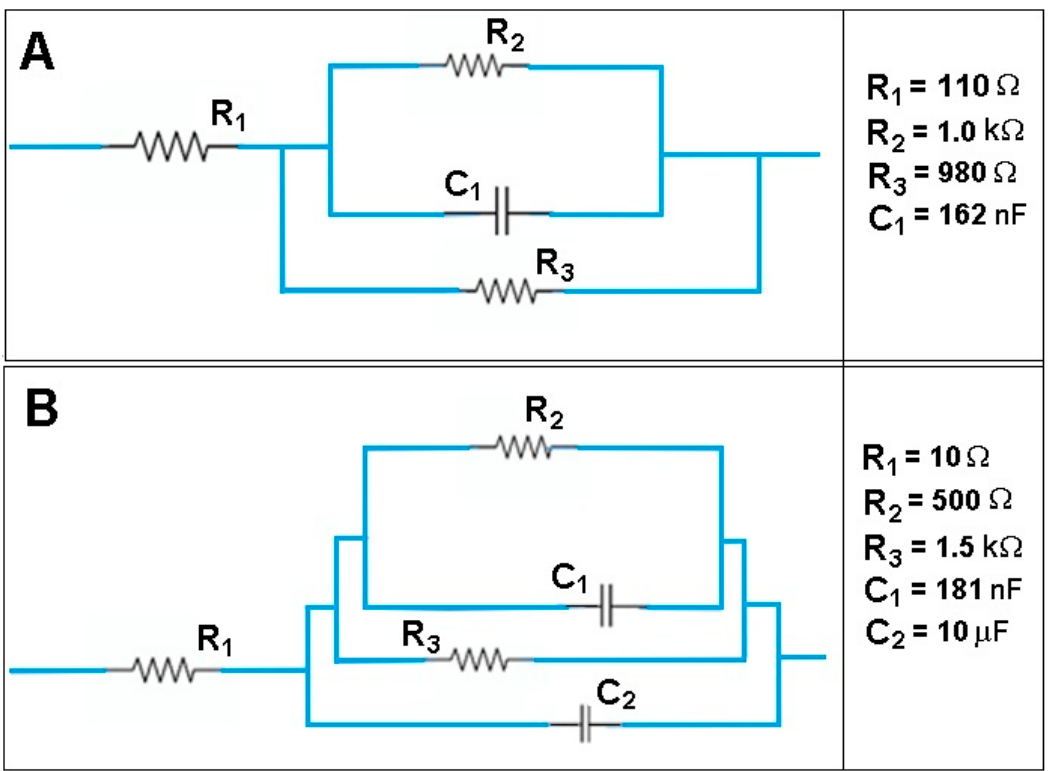
Figure 10. The equivalent circuits for CA/PEG membrane ( A ) and CA/PEG/CHI-Ag membrane ( B ).